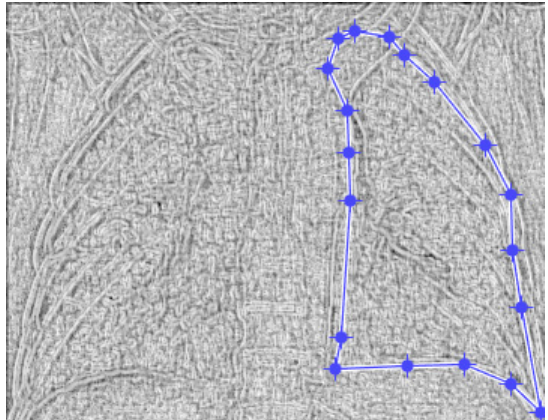
Figure 19. De fi ning the mask for the left lung of the fourth patient.